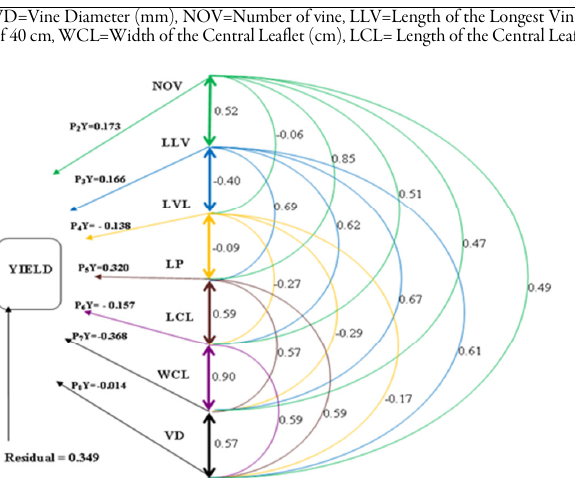
Fig. 1. Diagrammatic representation of direct and indirect influence of yield component traits on leaf yield of fluted pumpkin. PY=path through, VD=Vine Diameter (mm), NOV=Number of vine, LLV=Length of the Longest Vine (cm), LP= Number of Leaves per Plant, LVL= Number of leaves per vine length of 40 cm, WCL=Width of the Central Leaflet (cm), LCL= Length of the Central Leaflet (cm) and YIELD= Leaf